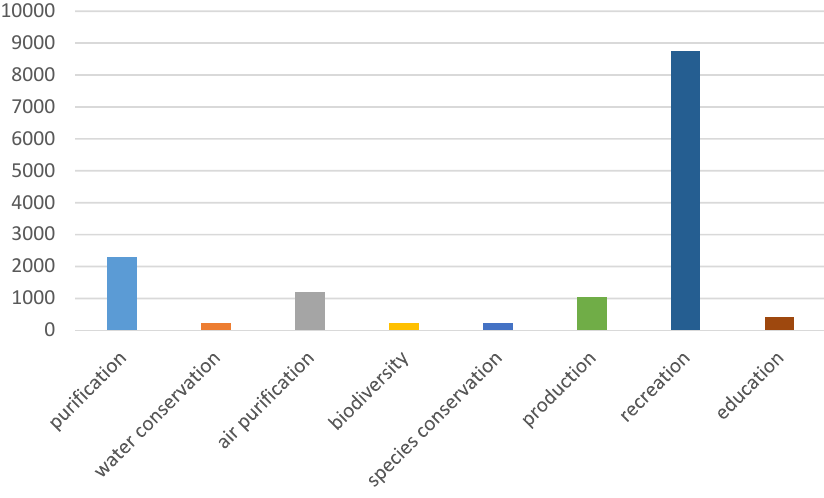
Figure 5. The composition of value in different service of Lakeside Wetland Park (unit: 10 4 CNY).